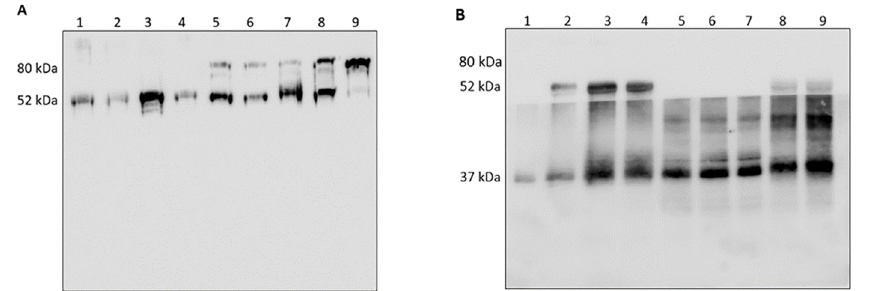
Figure 1. Panel ( A ). Western blotting with anti ‐ AAT antibody. Lanes 1–4: COVID ‐ 19 samples not showing the complex (80 kDa band) upon addition of exogenous HNE. Lanes 5–8: BOS samples showing the complex (80 kDa band) upon addition of exogenous HNE. Lane 9: complex generated “in vitro” upon incubation of the HNE and AAT standard proteins. Panel ( B ). Western blotting with anti ‐ AAT and anti ‐ HNE antibodies. Lane 1: free HNE standard protein. Lanes 2–9: different COVID ‐